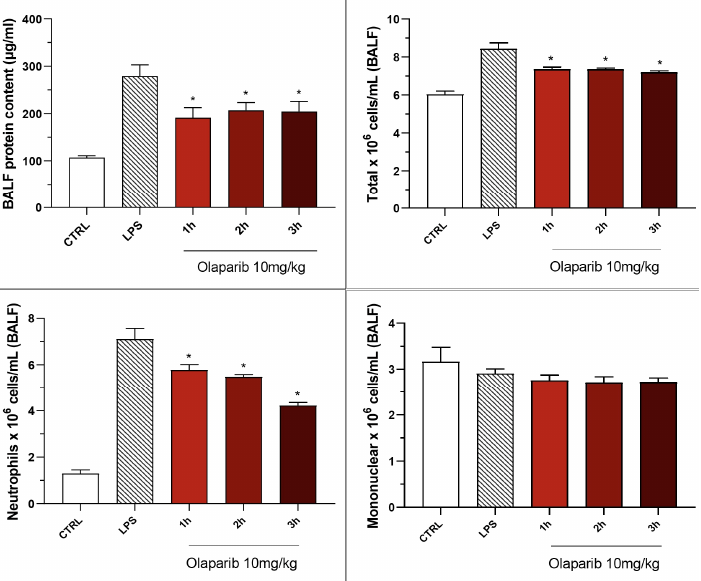
Figure 19. Effect of olaparib post-treatment on the protein and cell content of bronchoalveolar lavage fluid in a murine model of ALI. C57Bl/6 mice received either PBS (30 µL) or LPS (50 µg in 30 µL PBS) by intratracheal instillation in the absence or presence of 10 mg/kg olaparib, delayed to 1, 2, or 3 h post-LPS. After 24 h, bronchoalveolar lavage fluid was collected, and protein content was measured, and inflammatory cell numbers (total cell count as well as neutrophils and mononuclear cells) were quantified. * p < 0.05 indicates the beneficial effect of olaparib in LPS-treated animals. Data are shown as mean ± SEM, n = 8–12/group.